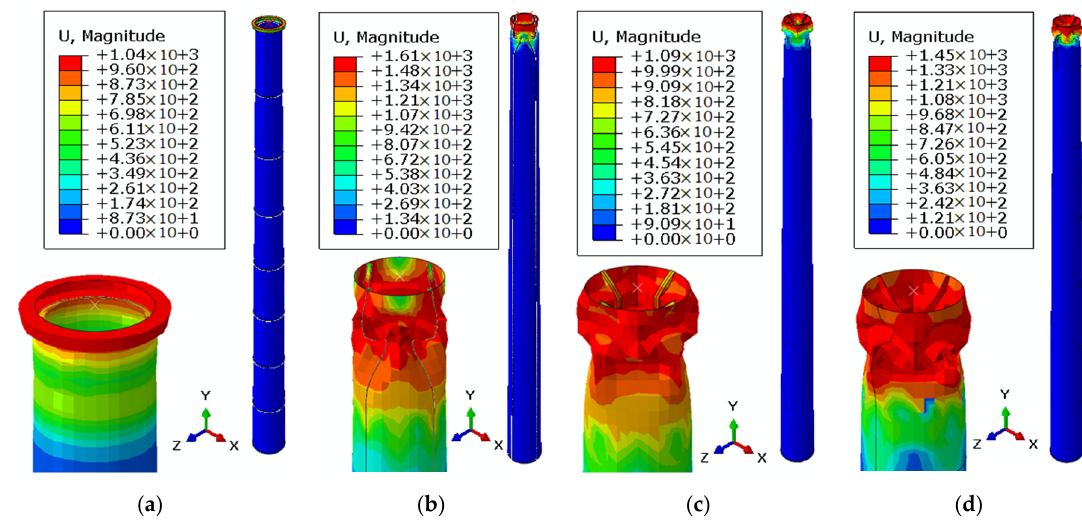
Figure 15. Post buckling behavior of Towers I, II, III, IV under gravity loading: ( a ) Tower I, ( b ) Tower II, ( c ) Tower III, ( d ) Tower IV, (in mm).